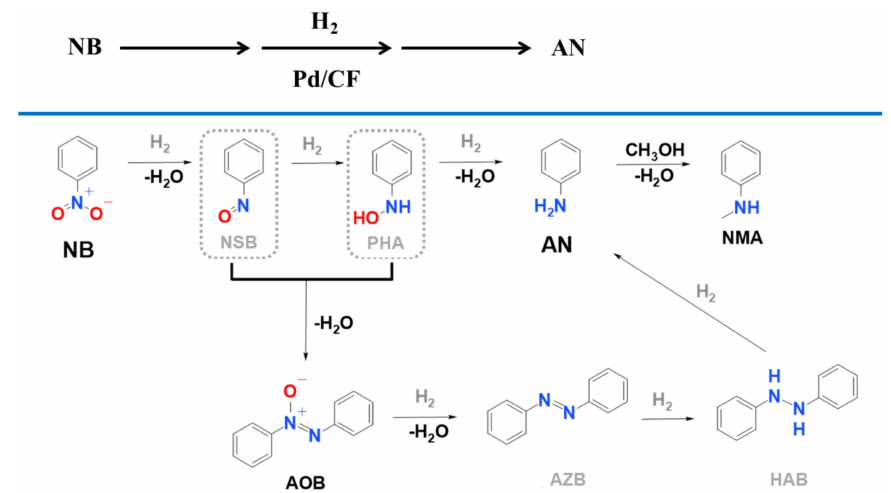
Figure 7. Proposed mechanism of nitrobenzene (NB) hydrogenation to produce aniline (AN) by using the developed palladium decorated carbon foil (Pd/CF) catalyst. The formation of azoxybenzene (AOB, intermediate) and N -methylaniline (NMA, by-product) is also shown along with undetected possible intermediates NSB (nitrosobenzene), PHA ( N -phenylhydroxylamine), AZB (azobenzene), and HAB (hydrazobenzene).